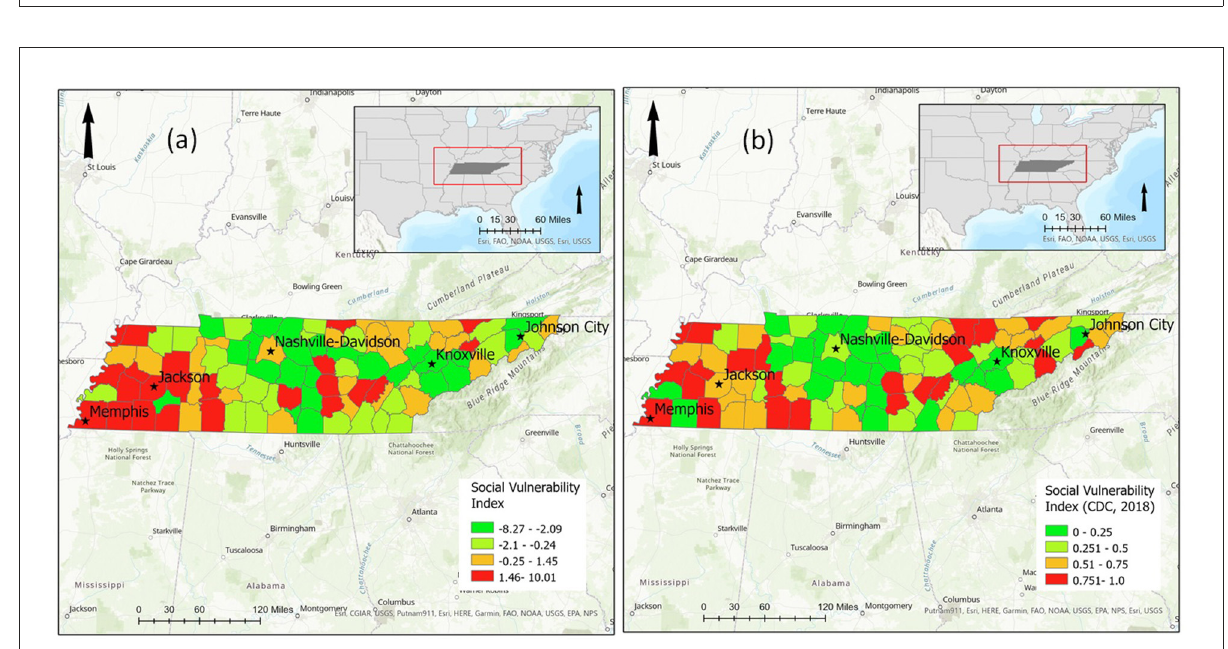
FIGURE4 Disadvantaged areas in Tennessee shown in red color using (a) the SDI and (b) the CDC-based SVI methods.